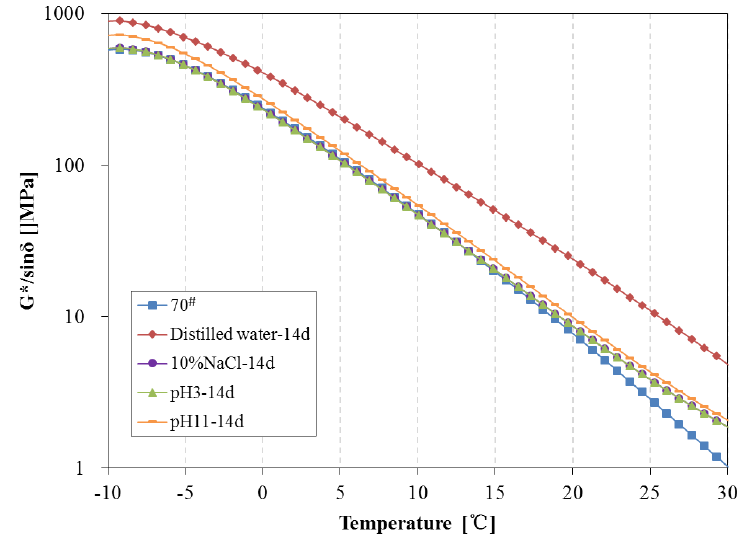
Figure 12. Rutting parameter of 70 # asphalt before and after 14 days immersion.